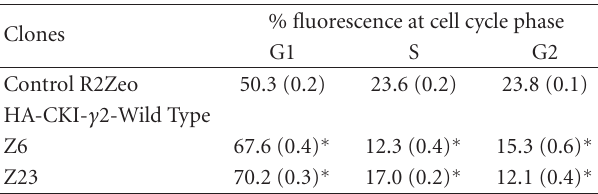
Table 2: Cell distribution in di ff erent phases of cell cycle deter- mined by FACS